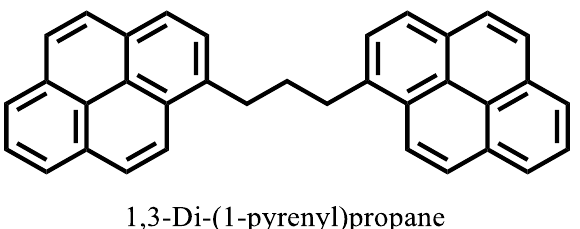
Figure 9. The non-heteroatom contains aromatic molecules, which report to Aro-3 and contain bridging C ar -C ar linkages, with the smaller aromatic cores consisting of three fused aromatic rings ( top row ) and those with four or more fused aromatic rings ( bottom row ).